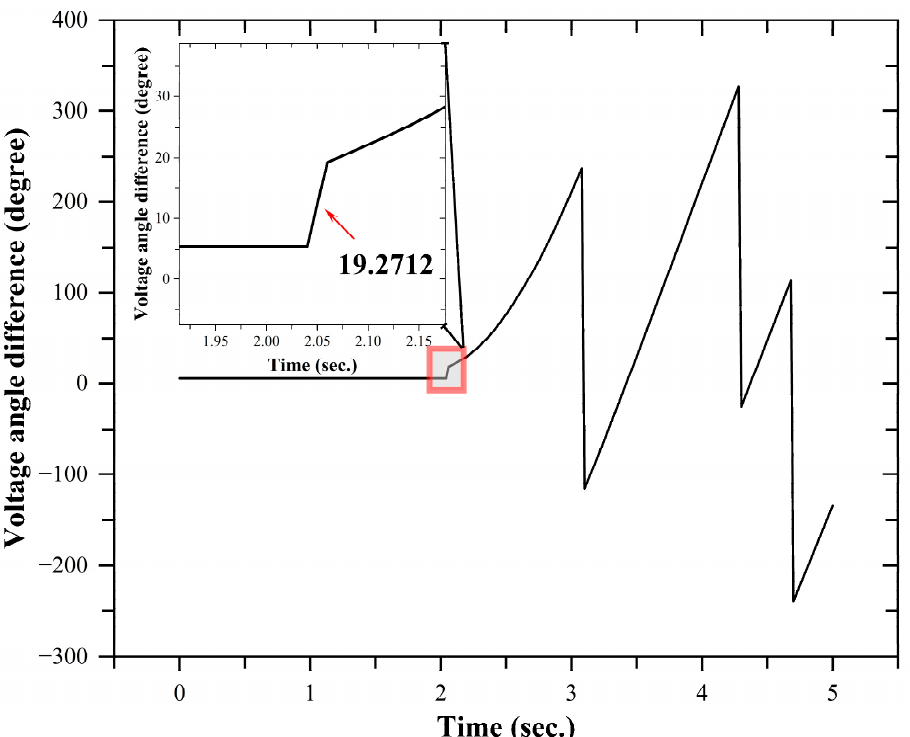
Figure 16. Proposed unintentional island threshold technique for over frequency Scenario 2.